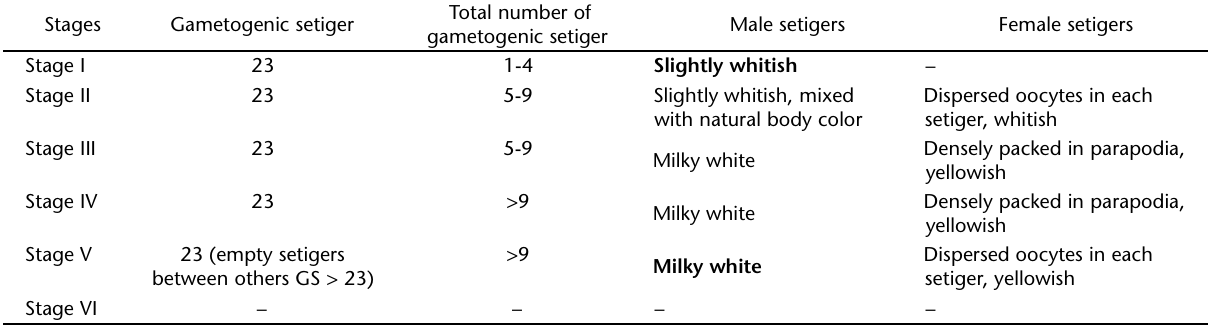
Table IV. Classification of the gonadal development stages, modified from J OYNER (1962) and R ICHARDS (1970). Note: characteristics registered only in this study are shown in bold. (GS) Gametogenic setiger.